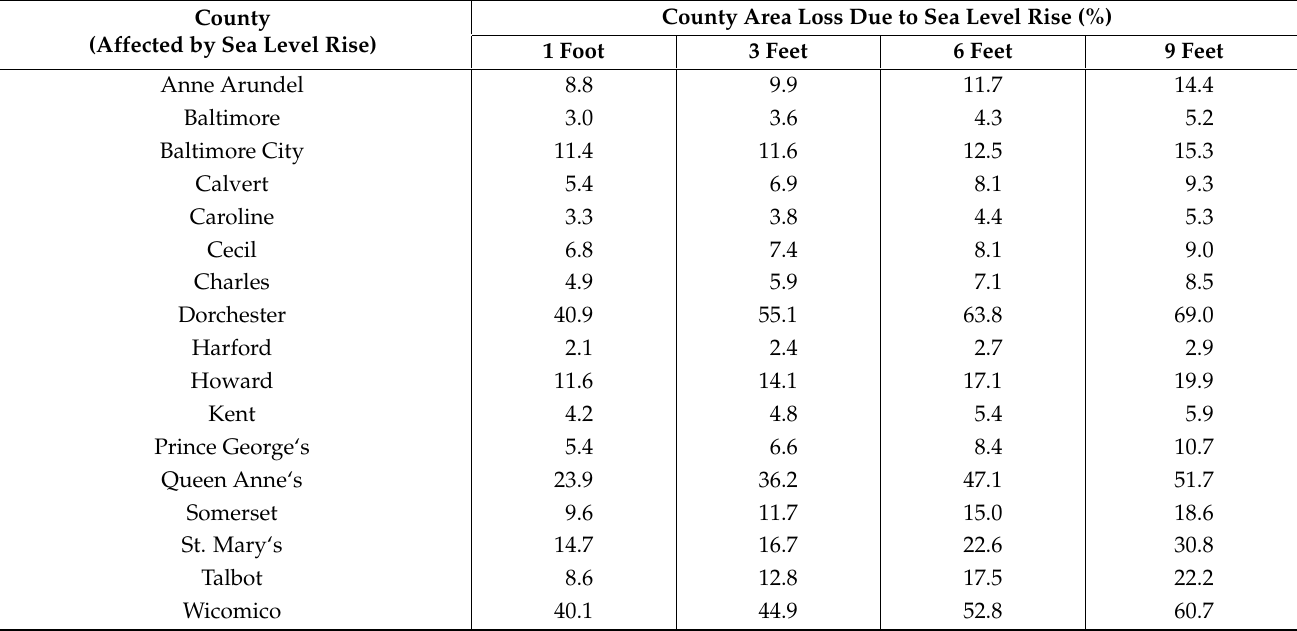
Table 10. Potential loss of county area (%) from sea level rise in Maryland, USA (from an original spatial analysis of data provided by the National Oceanic and Atmospheric Administration (NOAA)